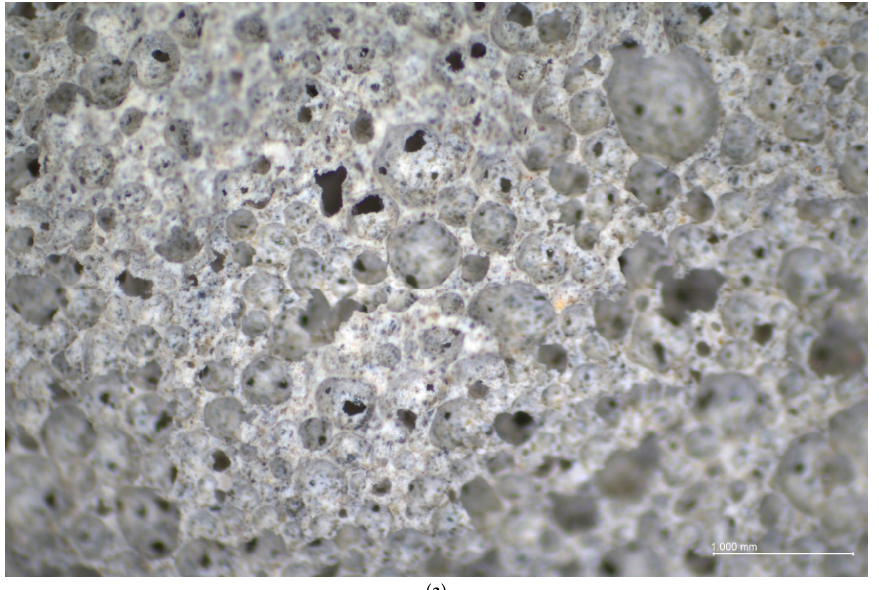
Figure 5. Size and distribution of pores in hardened foamed concrete samples with different densities: ( a ) 500 kg/m 3 (FC500), ( b ) 700 kg/m 3 (FC700), ( c ) 800 kg/m 3 (FC800).